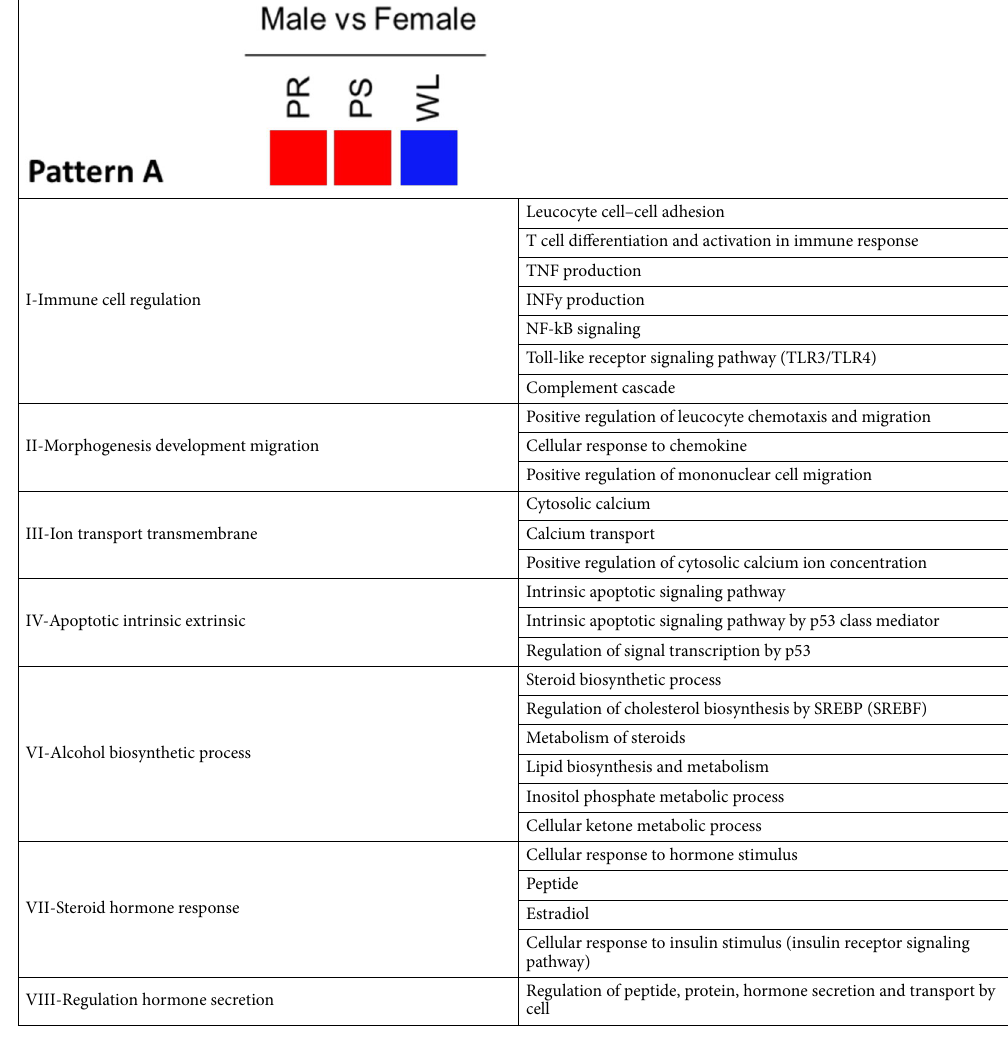
Table 6. Summary of clusters and gene sets included in the pattern A for the renal IRI sex